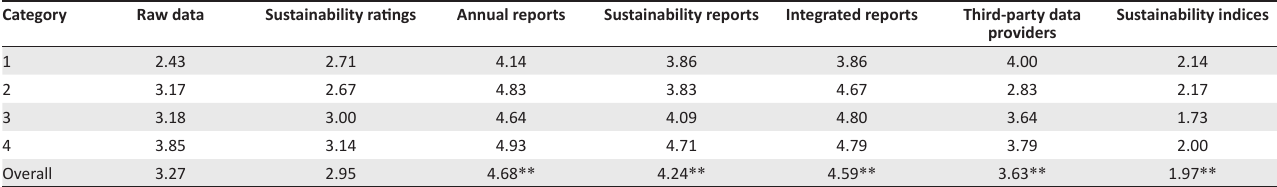
TABLE 6: Relevance of environmental, social and governance information sources. Category Raw data